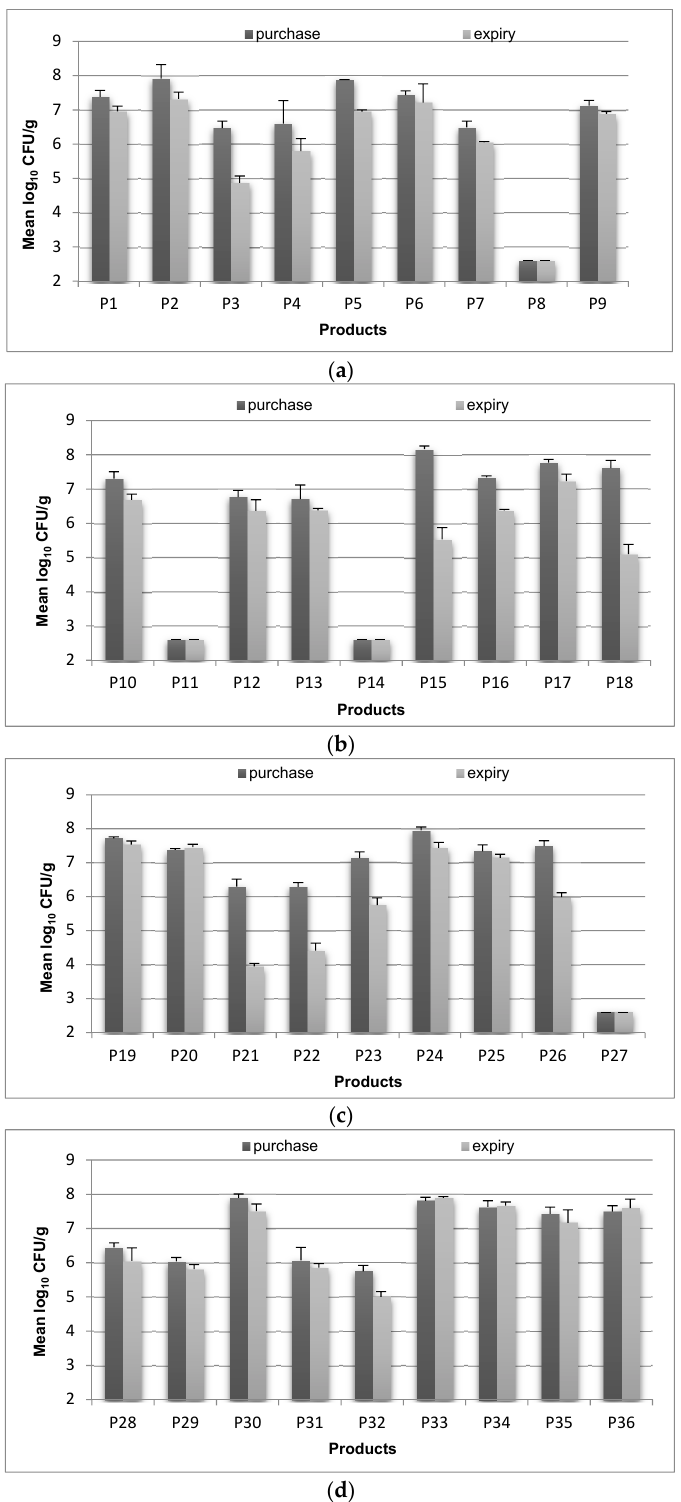
Figure 2. Bacterial count of presumptive Lactobacillus spp. strains (log 10 CFU/g) on MRS- Clindamycin agar in tested products at the time of purchase and at the end of expiry date at 37 °C after 48 h anaerobic incubation. Data are means ± SD (n = 4). P1–P36 are sample codes for tested probiotic